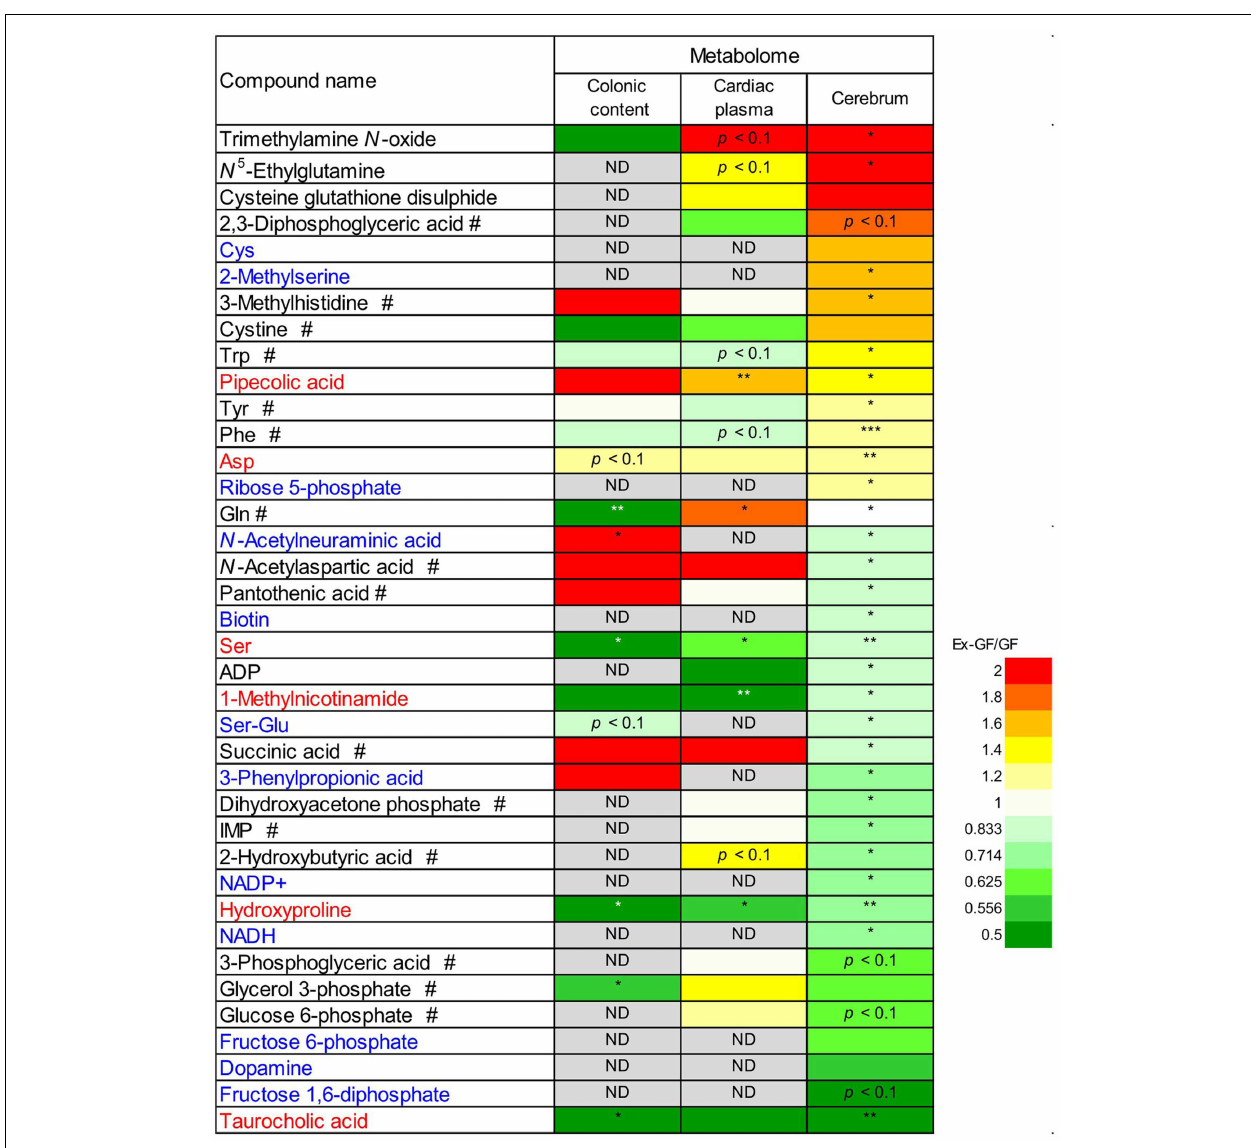
cerebrum. Metabolites shown in blue are below the detection limit in cardiac plasma, but were detected in the cerebrum. # These metabolites differed in Ex-GF/GF ratios between the cerebrum and cardiac plasma. * p < 0.05, ** p < 0.01, *** p < 0.001 (GF vs. Ex-GF). ND, not